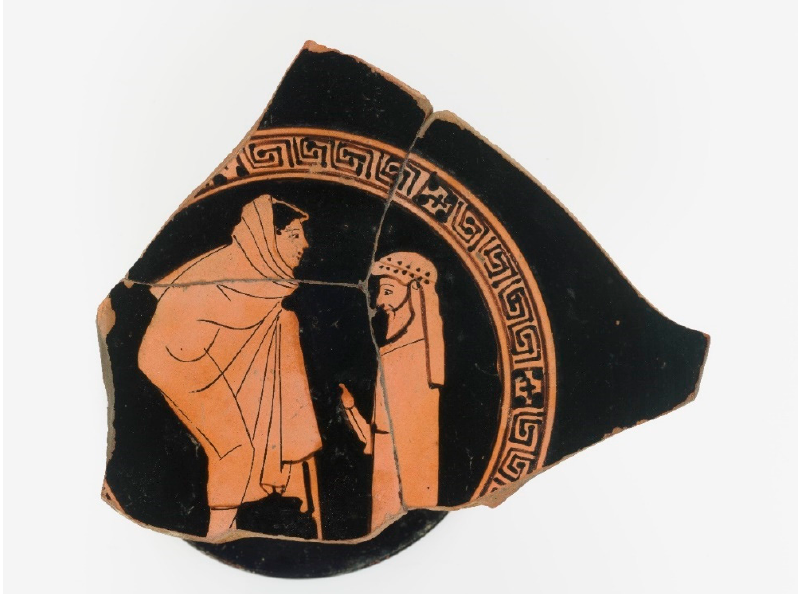
Figure 9. Interior of a fragmentary kylix attributed to the Tarquinia Painter. Paris, Musée du Louvre Cp11753. Photo by Hervé Lewandowski © RMN-Grand Palais/Art Resource, NY. Used by permission. Ca. 470 BCE.